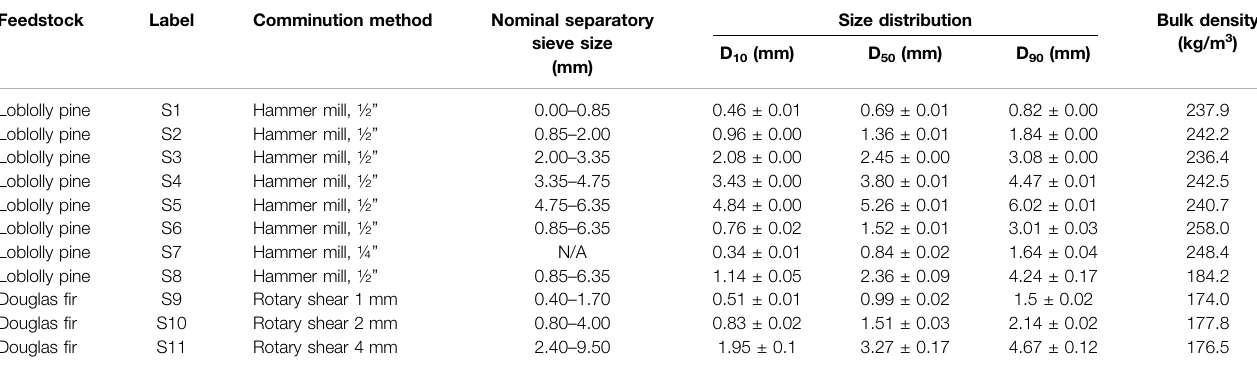
TABLE 1 | Size distribution and bulk density of the